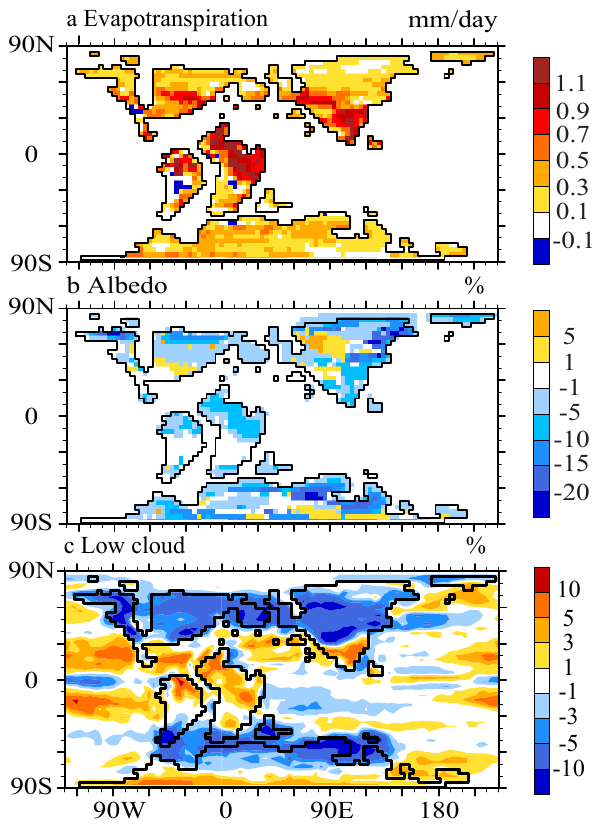
Fig. 6. Annual mean (a) total evapotranspiration over land (mm day − 1 ) ; (b) surface albedo (%); and (c) low cloud cover (%) for the 10xDGVM–10xBG experiments